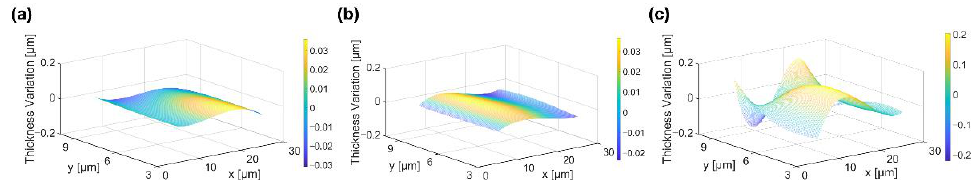
Figure 4. Thickness variation of 1D linear ultrasound transducer arrays ( a ) without acoustic matching layer, ( b ) with the FPCB matching layer, and ( c ) with the alumina/epoxy matching layer.